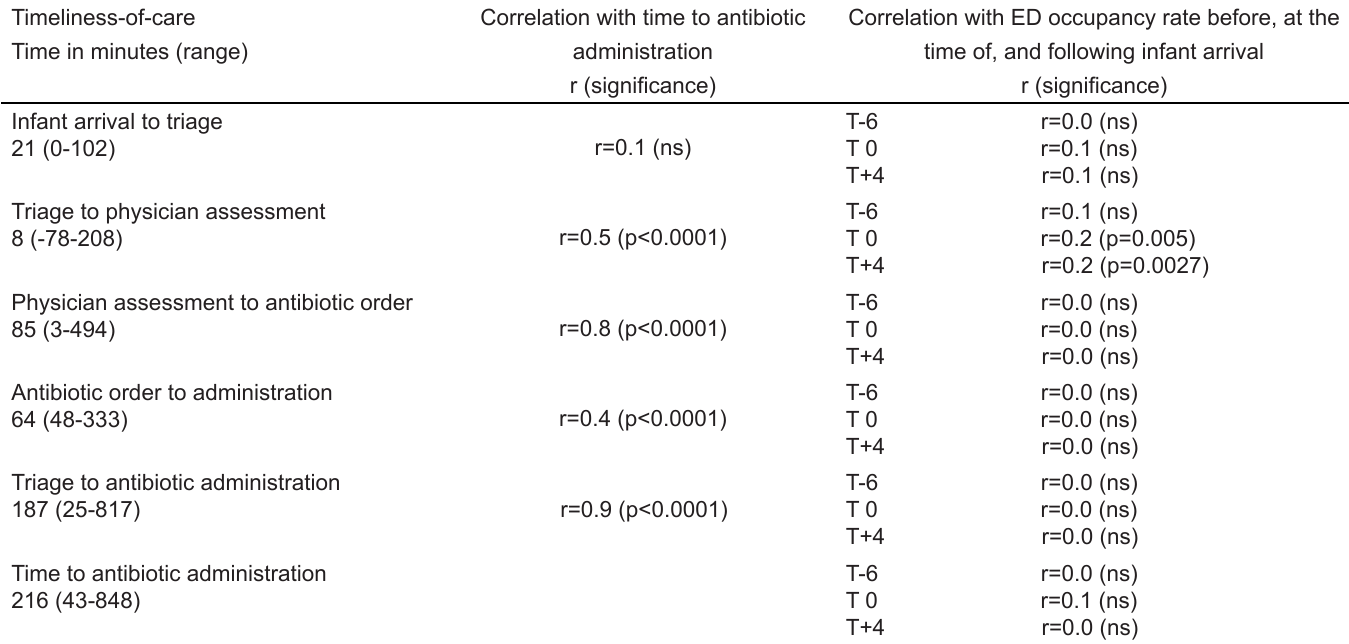
Table 2. Correlation of timeliness-of-care measures with overall time to antibiotic administration and emergency department (ED) occupancy rate. Time to antibiotic administration is defined as the time in minutes from infant arrival to antibiotic administration. Non- significant (NS) at p>0.05. T-6 represents hour 6 prior to infant presentation; T0 represents time of infant arrival and T+4 represents hour 4 following infant